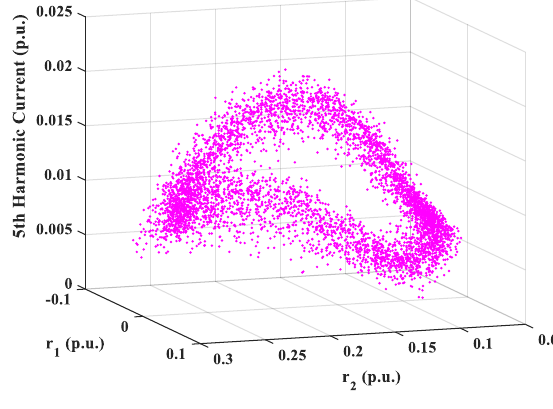
Figure 8. EAF model simulating flicker disturbance.